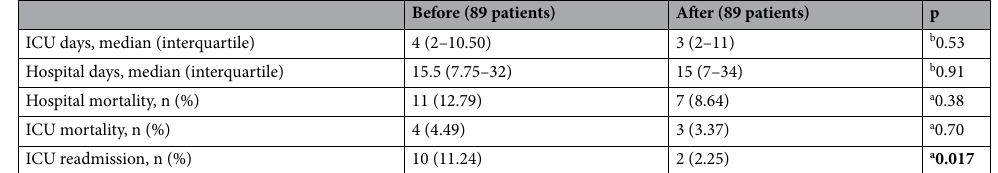
Table 5. Hospital and ICU length of stay, hospital and ICU death and readmission rate. Bold values denote statistical significance at the p ≤ 0.05 level. a Pearson Chi-Square, b Mann–Whitney.